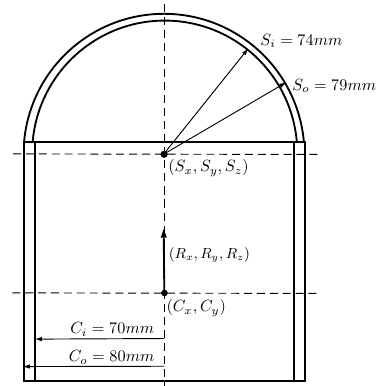
Figure 14. Cross-section representation of the PMMA waterproof